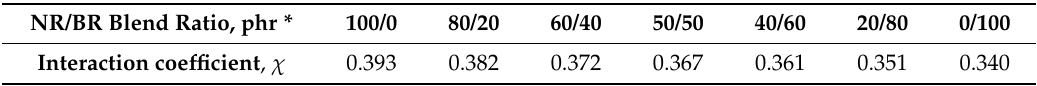
Table 2. Interaction coefficient of the polymer-solvent.